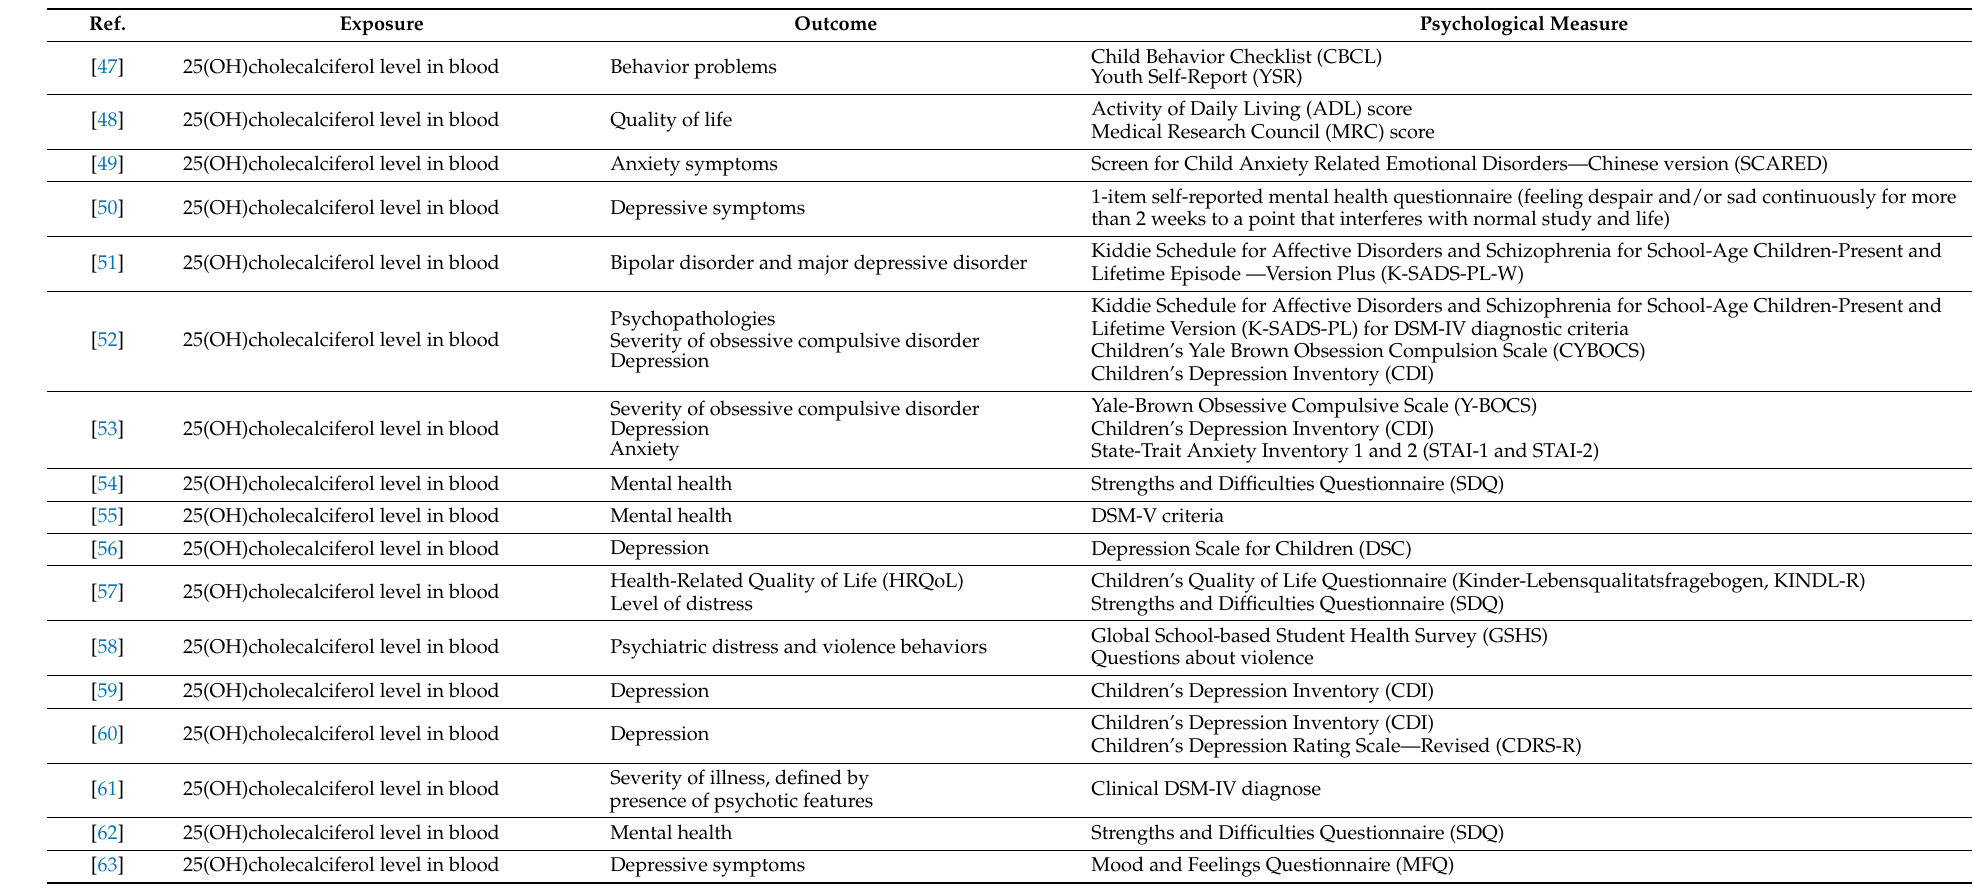
Table 8. The exposure, intervention and outcome of the included observational